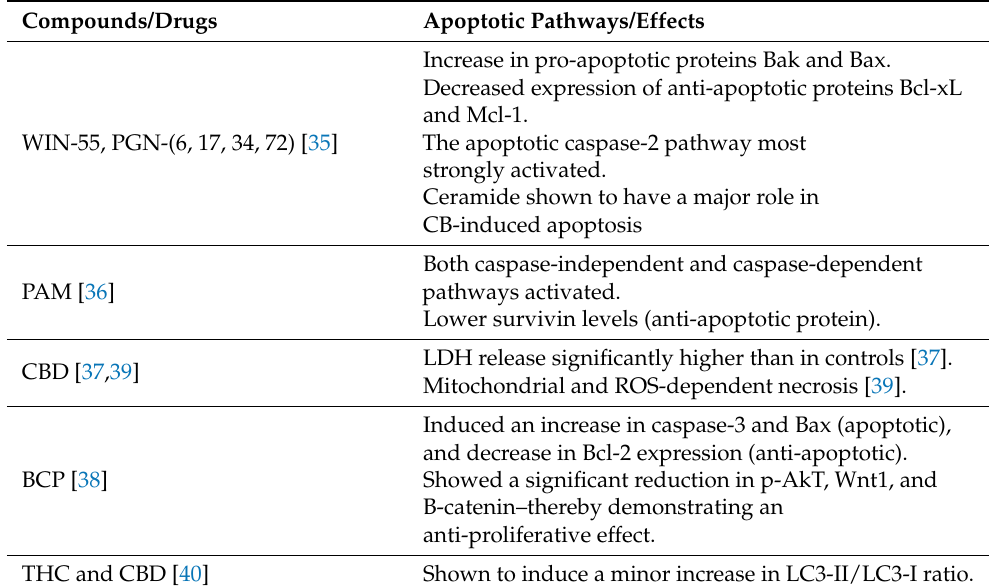
Table 3. Compounds/drugs and corresponding apoptotic pathways/effects.